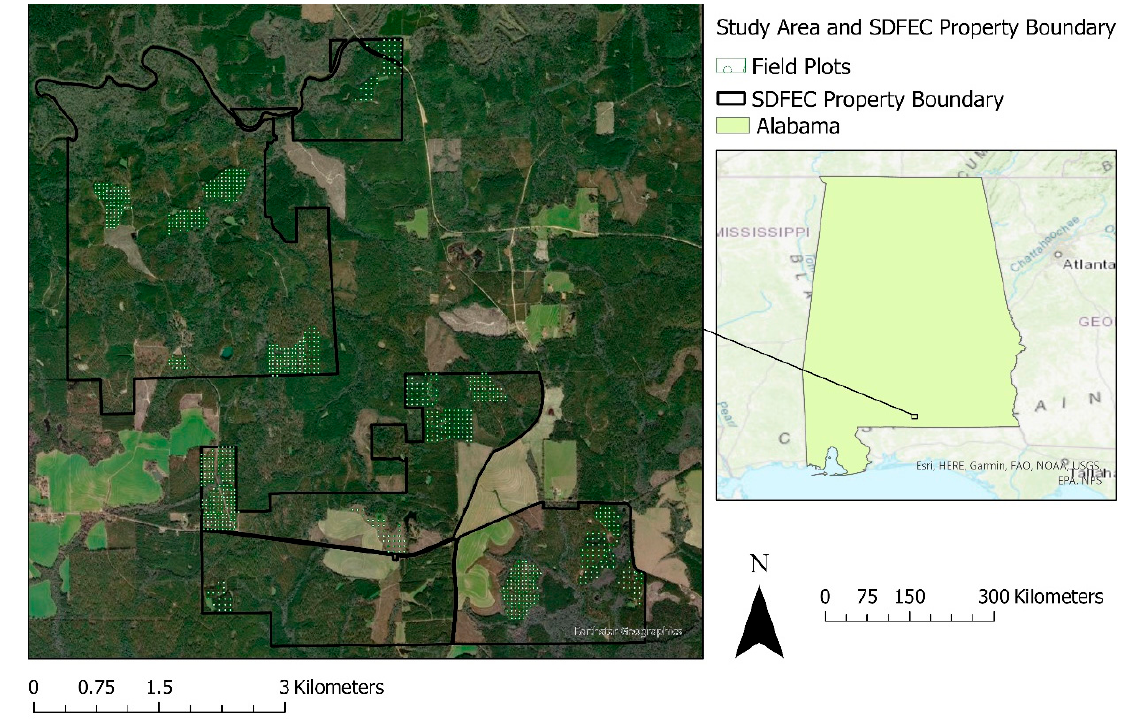
Figure 1. Study site with SDFEC property boundary and field plots, ESRI “World Imagery” [46] .